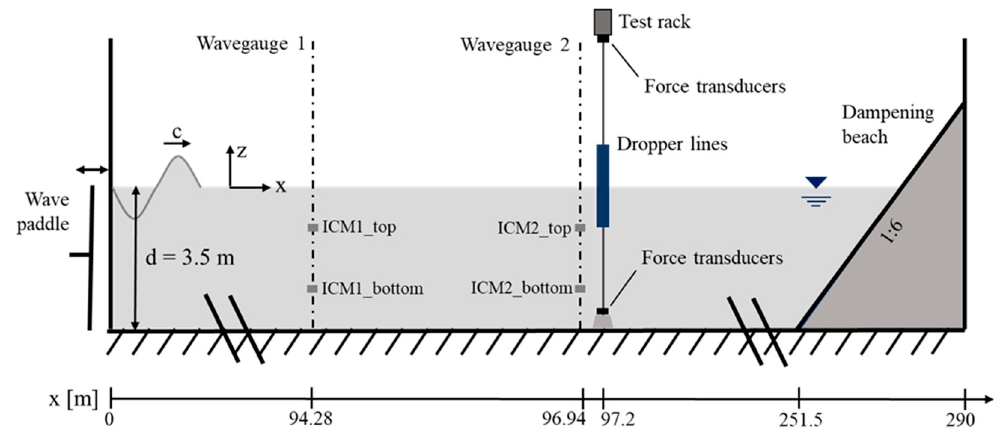
Figure 1. Side view of the Large Wave Flume with wave paddle, measuring equipment, test rack with mussel dropper lines and wave dampening beach (sketch not to scale).